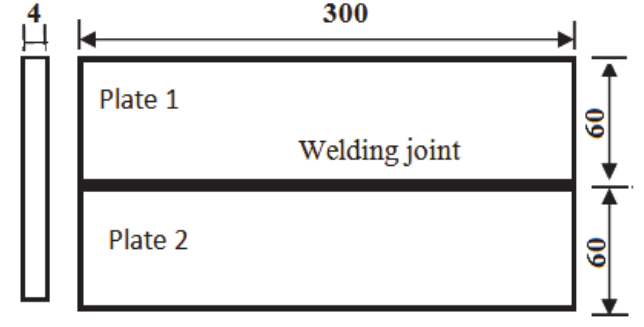
Figure 4: FSW welding